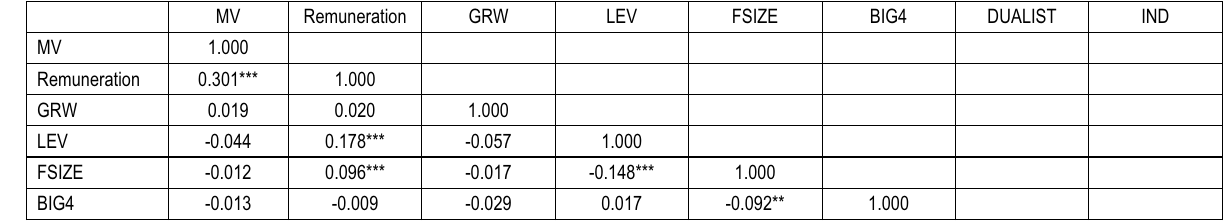
Table 5. Multicollinearity for ROA and Market Value